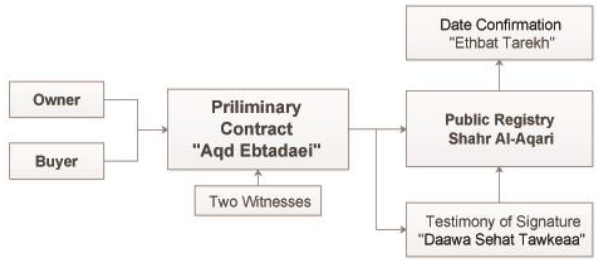
Figure 2: Legalizing of Private Property, Source: Researcher